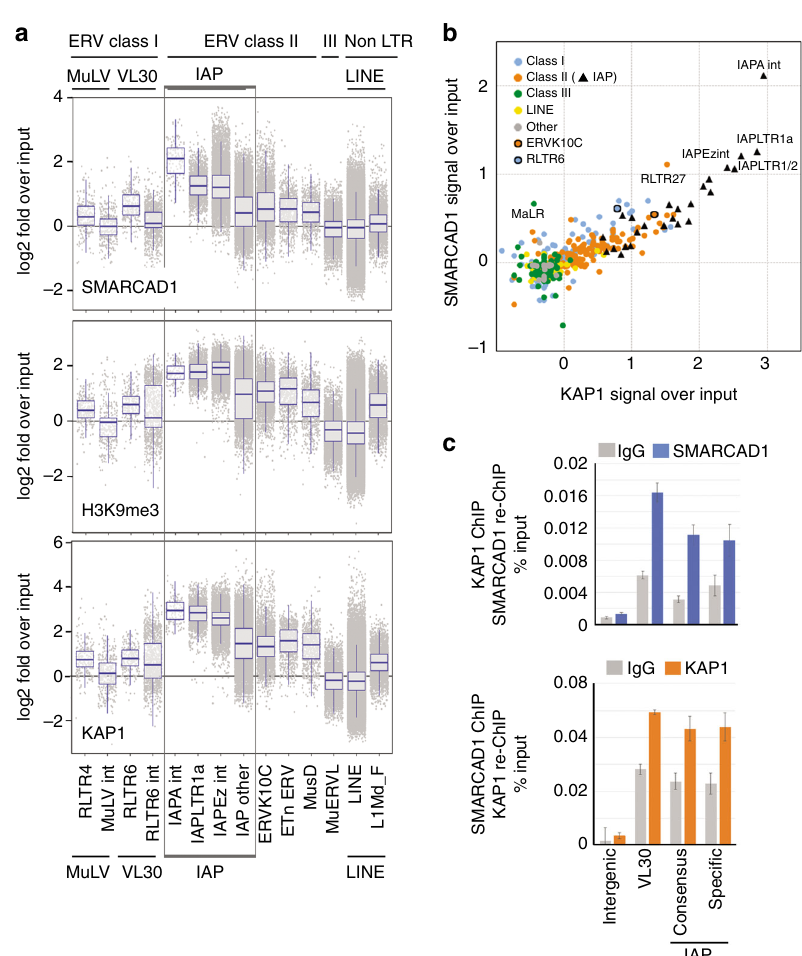
Fig. 2 SMARCAD1 co-occupies classes I and II ERVs with H3K9me3 and KAP1. a Comparison of SMARCAD1 (top, this study), H3K9me3 (middle, this study) and KAP1 (bottom 34 ) enrichment at various repeat classes in mESCs. Combined box- and jitterplot depicting log2 fold ratio over input of normalized read counts (TPM) in the indicated ChIP-seq experiments (log2 (TPM ChIP/TPM Input)). In the boxplot center lines show the median; lower and upper box lines correspond to 25th and 75th percentiles, while whiskers extend from the hinge to the smallest (largest) datum not further than 1.5 times the interquartile range. Each dot represents a single repetitive element. Repeat subfamilies were categorized according to their UCSC RepeatMasker annotation. “ int ” indicates that the repeat is an internal ERV sequence. LTR long terminal repeat. IAP elements are boxed: IAPA_MM-int, IAPEz-int and IAPLTR1a are the most enriched elements, followed by “ IAP other ” which represents all other IAP elements. LINE: all repetitive elements of the repeat family LINE, except L1Md_F. L1Md_F was analysed separately as it was reported to exhibit high KAP1 enrichment 20 . See also Supplementary Figure 3a. b Comparison of SMARCAD1 and KAP1 binding on retrotransposons reveals strong enrichment of both proteins at IAP subfamilies (black triangles). A correlation of binding over several classes I and II ERV family members is apparent. Data points represent median signals over input of SMARCAD1 ChIP- seq data from PGK12.1 ESCs and KAP1 data from ref. 34 . c SMARCAD1 and KAP1 co-occupancy at ERV elements of class I (VL30) and class II (IAPs) in mESCs was assessed by sequential re-ChIP using SMARCAD1 and KAP1 antibodies followed by qPCR. Consensus IAP primers recognize the 5 ’ UTR, input values are mean ± S.E. of technical triplicates (Fig. 3a, for example MuLV and MMERVK10C). KAP1 ChIP-Seq in ESCs depleted for SMARCAD1 corroborated that SMARCAD1 loss is accompanied by a reduction of KAP1 occupancy at IAPs (Supplementary Figure 5a, b). ChIP-qPCR analysis following a 2- day depletion of SMARCAD1 moreover showed a subtle, repro- ducible reduction of KAP1 at other ERV families (Supplementary Figure 5c). These reductions are not the result of a global decrease of KAP1, H3K9me3, or H4K20me3 levels upon SMARCAD1 knockdown (Fig. 1b and Supplementary Figure 4f) 25,27 . Re- expression of SMARCAD1 restored reduced H3K9me3 levels (Fig. 3c, KD + SMARCAD1) and KAP1 binding (see below) observed at IAPs and MMERVK10C elements after the depletion